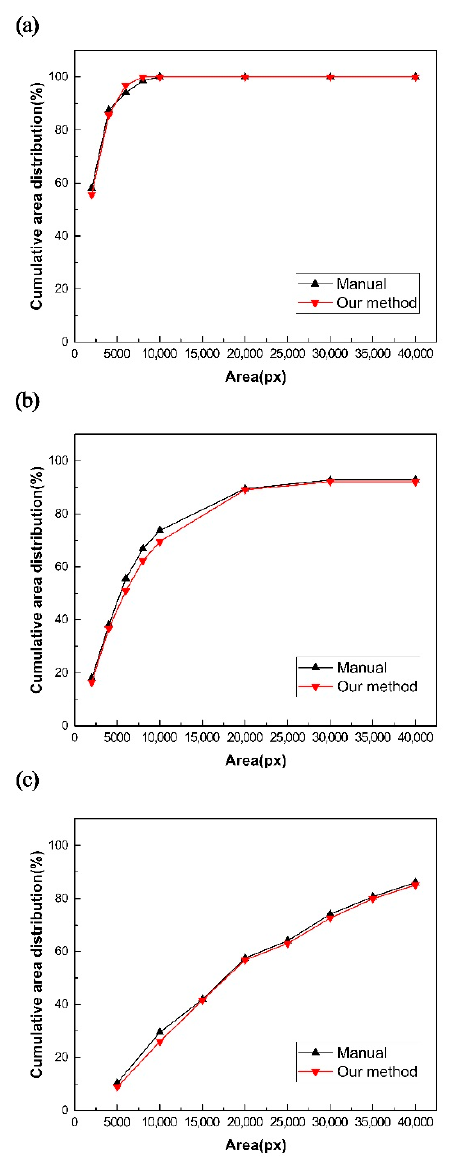
Figure 11. The results of the specified images processed by our method: fine material ( a ), mixed materials ( b ), and coarse materials ( c ).